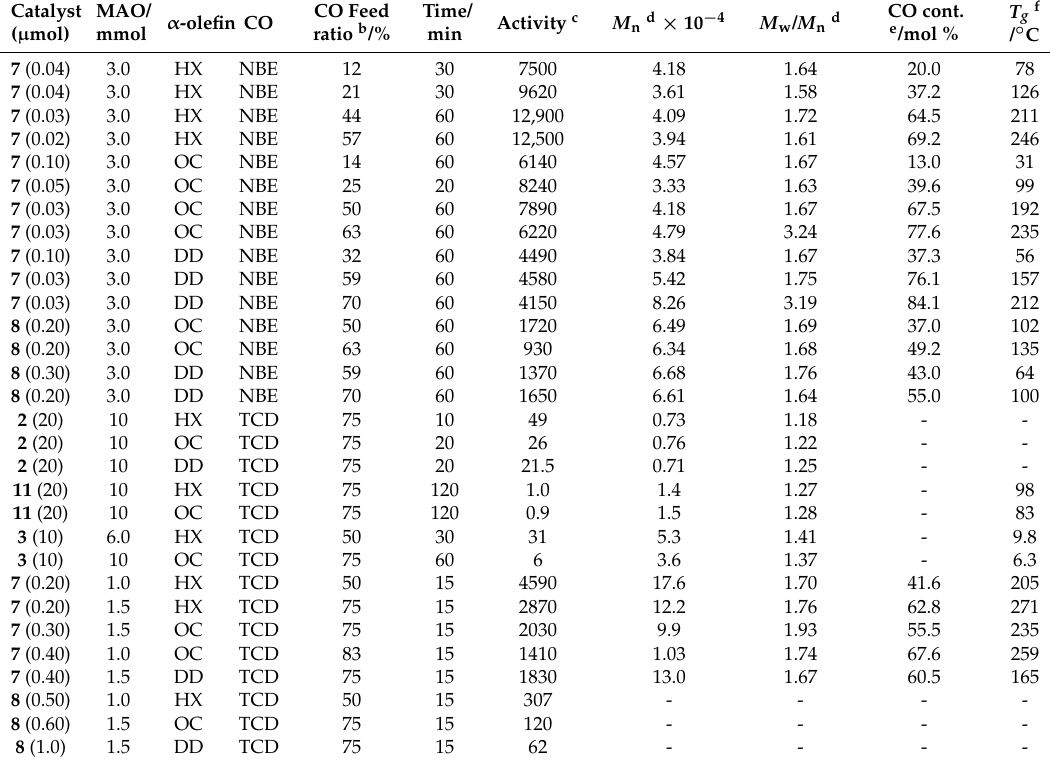
Table 3. Copolymerization of norbornene (NBE) or tetracyclododecene (TCD) with 1-hexene (HX), 1-octene (OC), and 1-dodecene (DD) by [Et(indenyl) 2 ]ZrCl 2 ( 2 ), Cp 2 ZrCl 2 ( 11